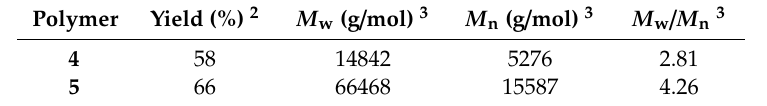
Table 1. Data from the cross-coupling polymerisation of Calix-OCPs ( 1 and 2 ) with 2,7-CBZ ( 3 ) 1 .